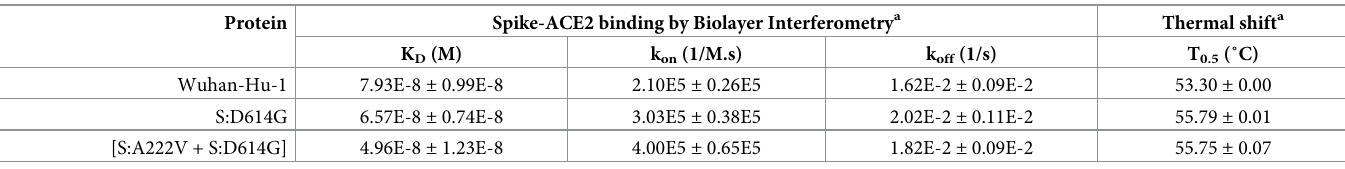
Table 1. In vitro functional assays.